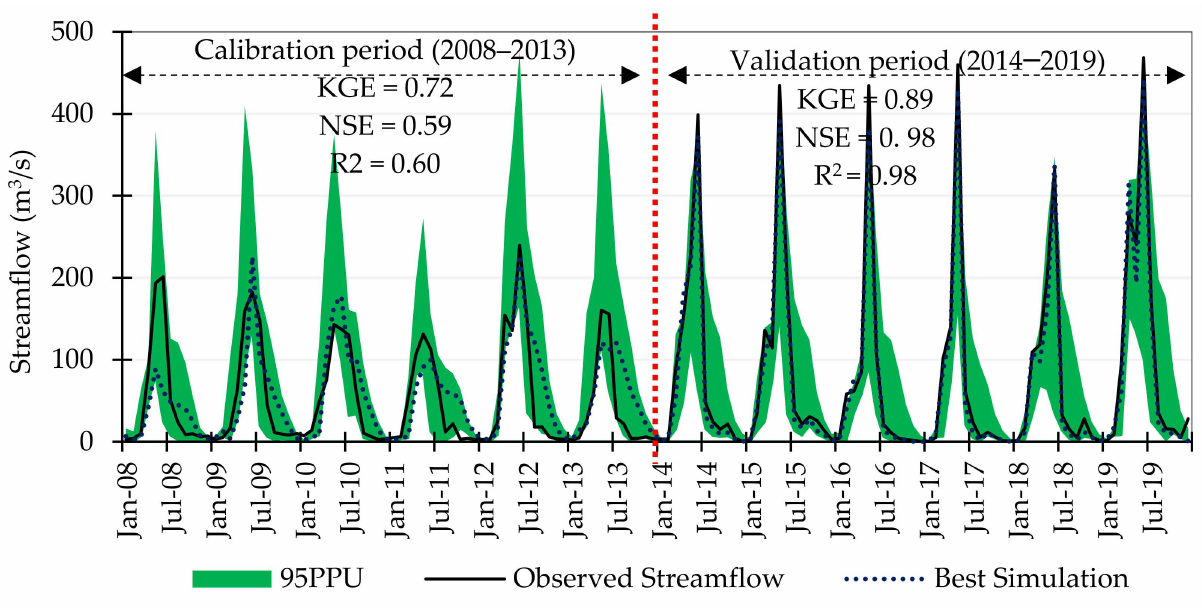
Figure 7. Calibration (2008–2013) and validation (2014–2019) of the SWAT